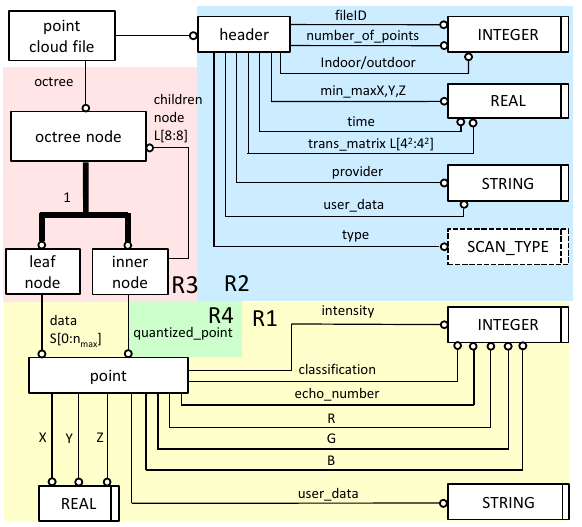
Figure 2. Data structure of the general point cloud data format represented in EXPRESS-G